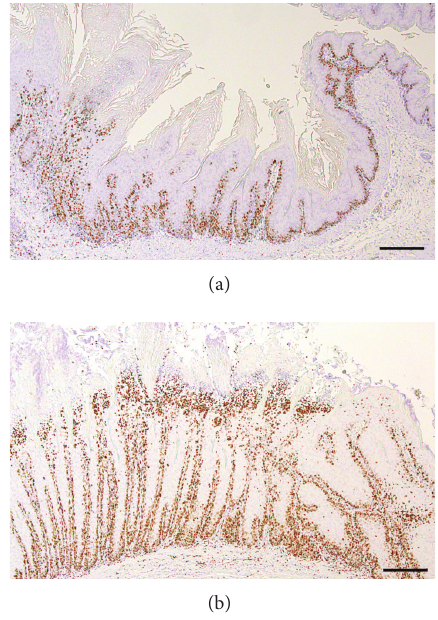
Figure 3: Cellular proliferation of mucosal epithelium induced by C. albicans. The Ki-67 positive cells of mucosal epithelium are increased in the AL group (a) compared to the AC group (b). Scale bar, 200 𝜇 m.